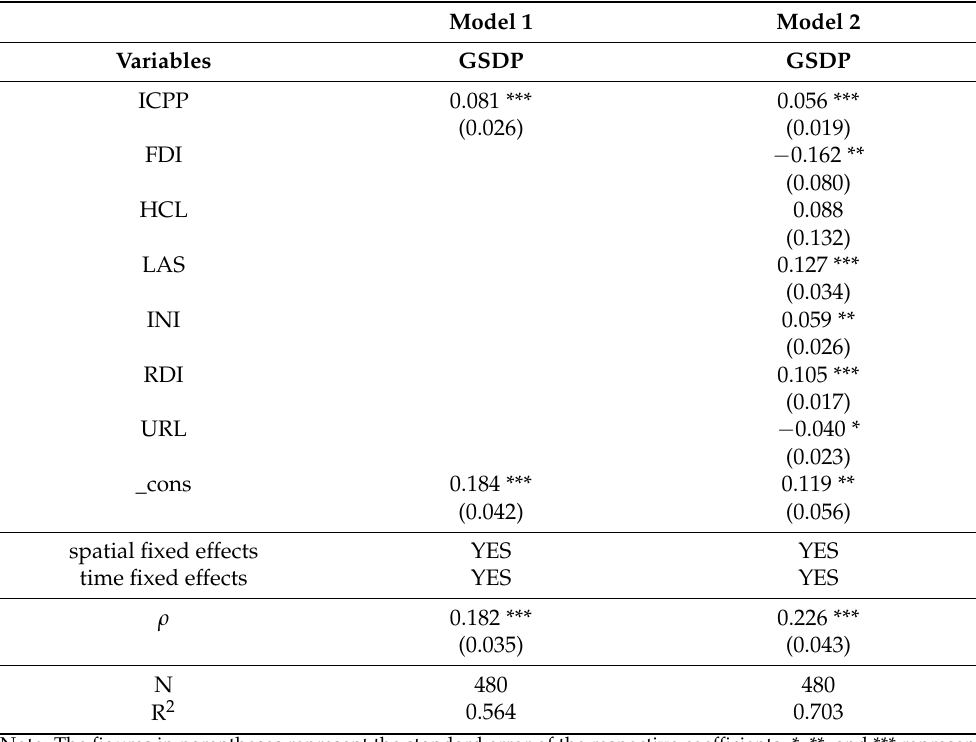
Table 4. The benchmark regression